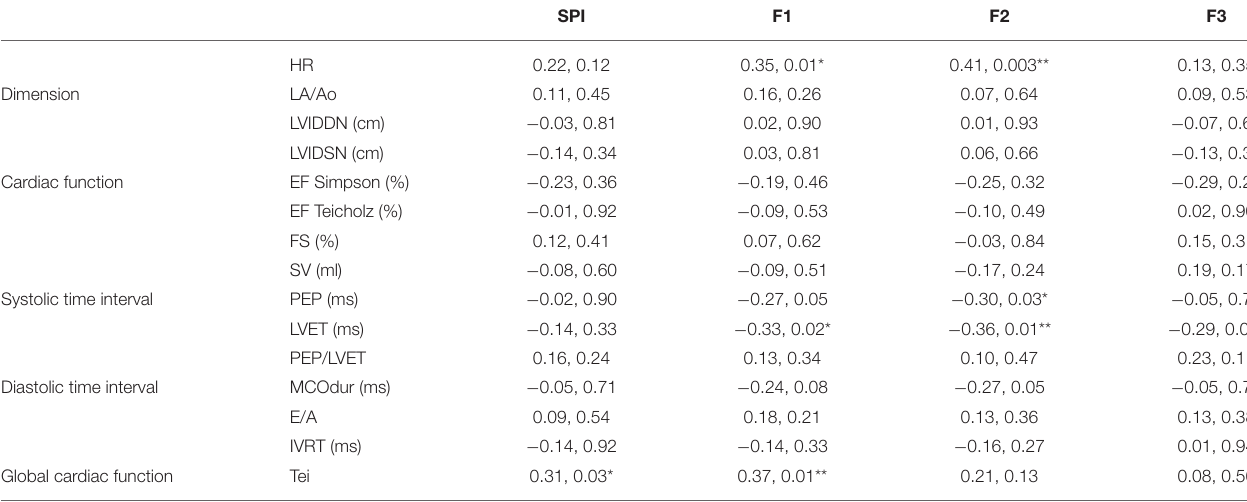
TABLE 4 | Relationship of CTI parameters between standards trans-thoracic echocardiography and simultaneous ECG and PCG